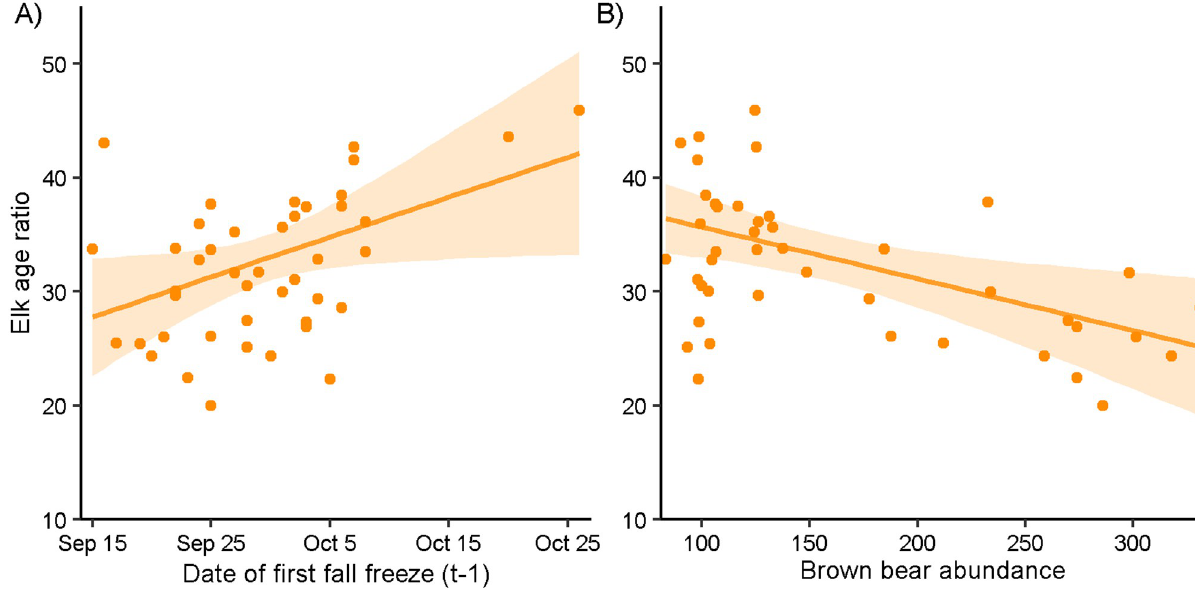
Fig 4. Island-wide elk age ratios predicted by date of first fall freeze and brown bear abundance. Model-predicted response of semi-annual island- wide elk age ratios (calves per 100 adult females) as a function of (A) date of first fall freeze in the previous year and (B) brown bear abundance with 95% credible intervals (shading), Afognak and Raspberry islands, Alaska, USA, 1967–2013.